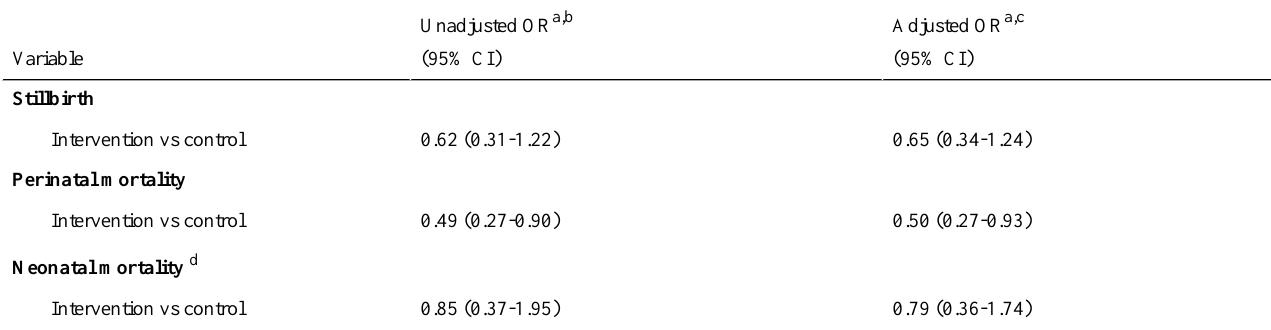
Table 4. . Intervention association with secondary